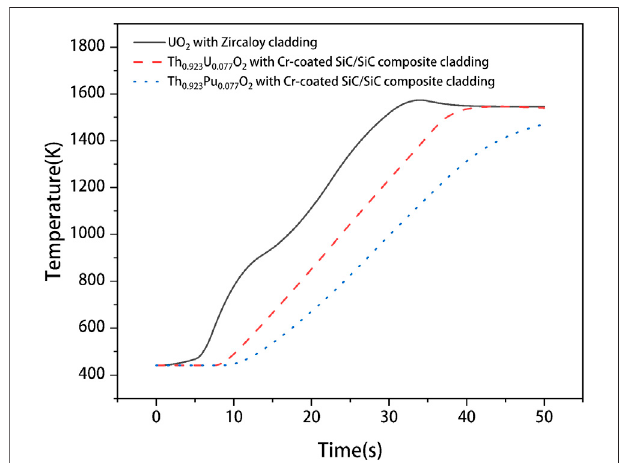
FIGURE15| Fuelcenterlinetemperature evolutionsfortheUO 2 fuelwith Zircaloy cladding, the Th 0.923 Pu 0.077 O 2 fuel, and Th 0.923 U 0.077 O 2 fuel with Cr- coated SiC/SiC composite cladding under LOCA